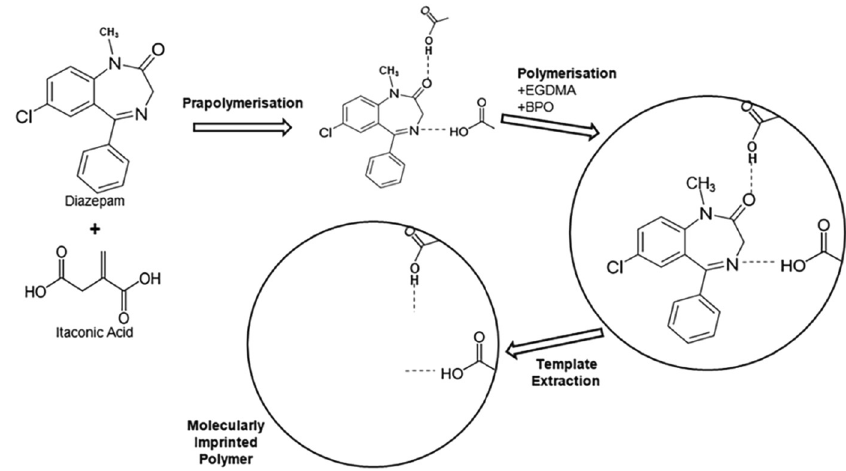
Figure 2: The synthesis scheme of MIP DZP with itaconic acid as a monomer.